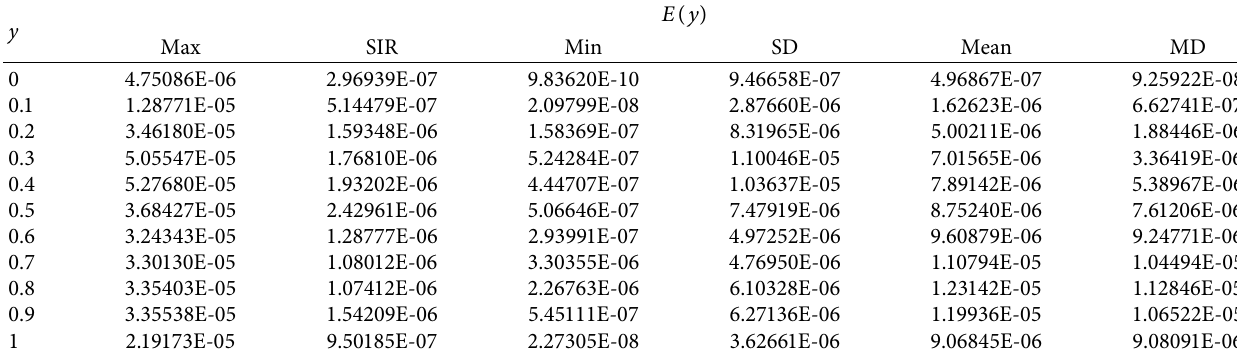
Table 3: Statistical performances for the class E ( y ) to solve the mathematical SEIR-NDC system.